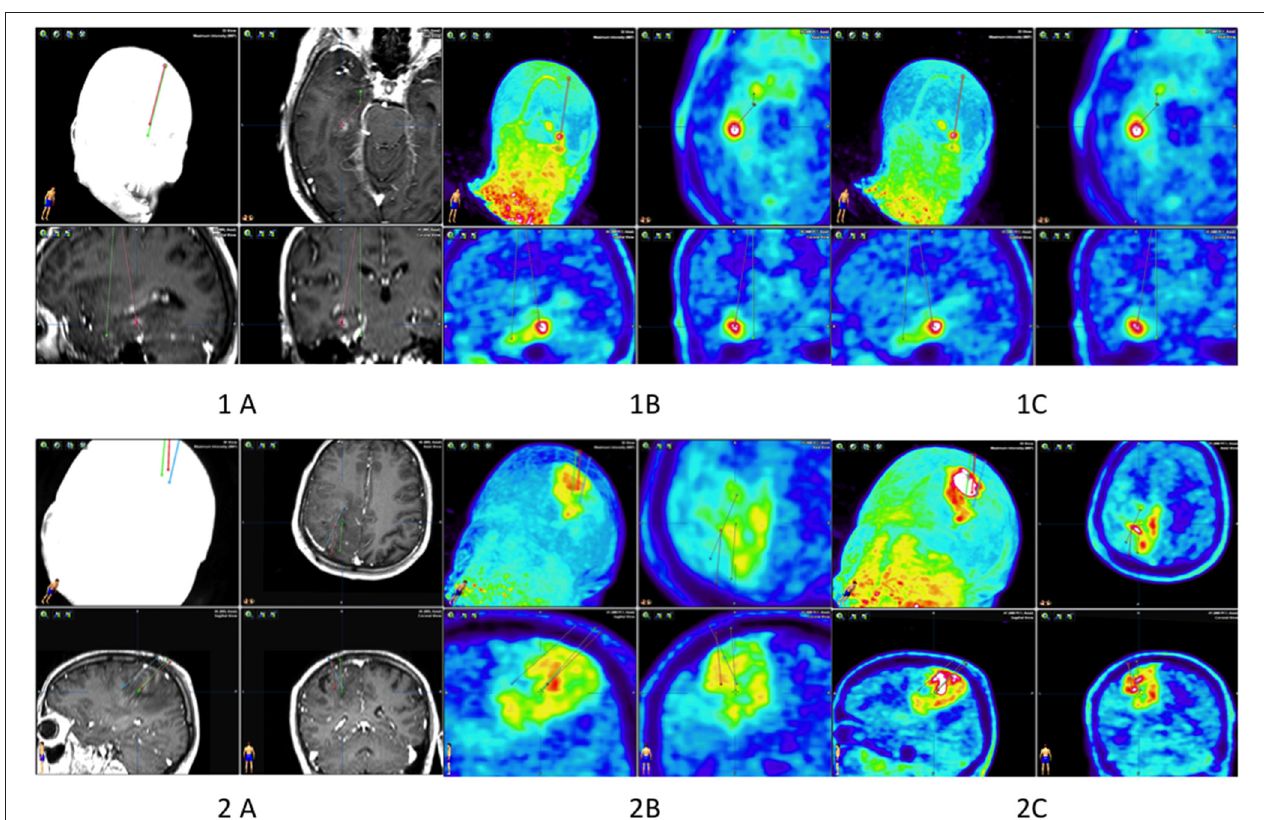
FIGURE 1 | Biopsy planning of patients 1 and 2. Patient 1: two biopsy trajectories in the MRI (A) , in PET 10 (B) , and in PET 60 (1C) . Patient 2: three biopsy trajectories in the MRI (A) , in PET 10 (B) , and in PET 60 (2C) .